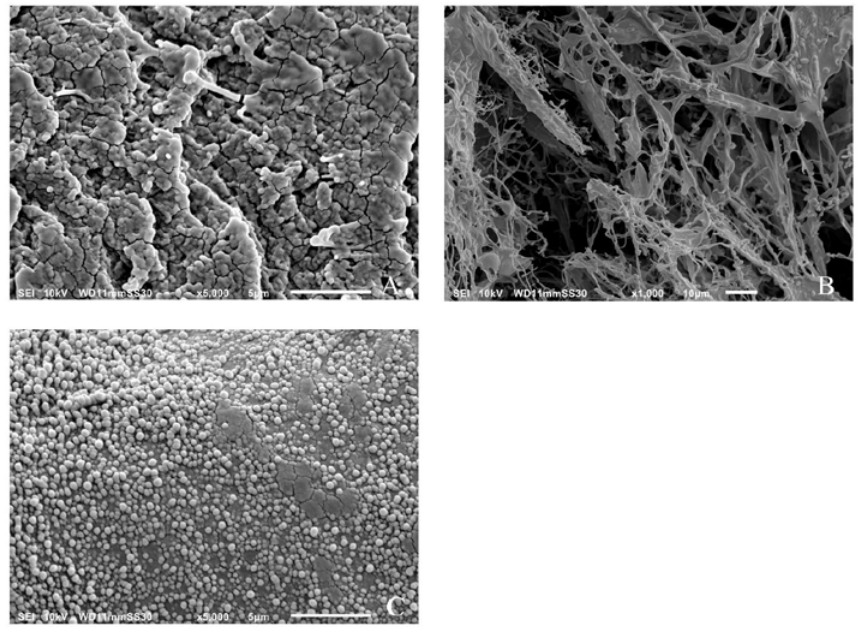
Figure 4. Scanning electron micrograph images of air-dried ( A ), freeze-dried ( B ), and freeze-dried/homogenized ( C ) α -glucans.